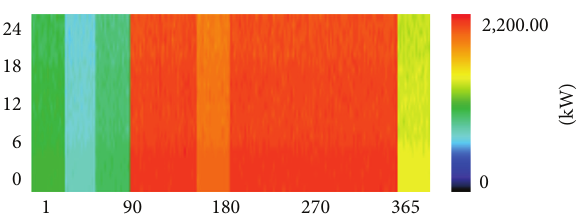
Figure 18: Hydroelectric output.